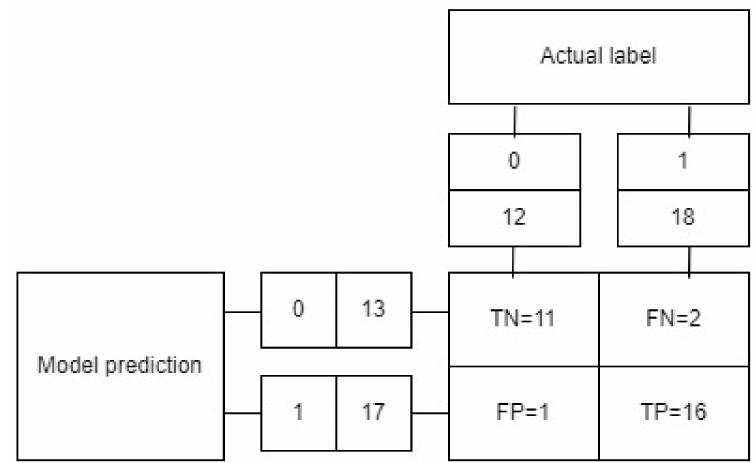
Figure 3. The confusion matrix of the results. Table 14. Results of the comparison of